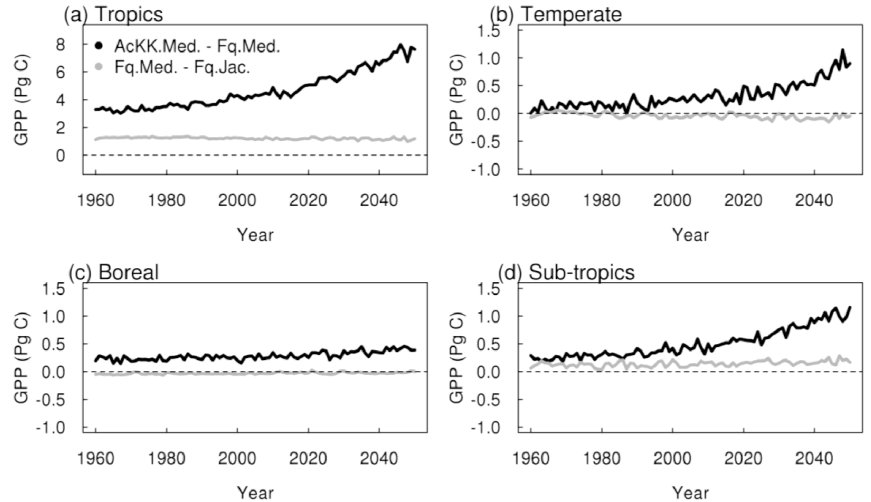
Figure 8. Time series of the regional mean acclimation effect, i.e AcKK.Med–Fq.Med (black), and the effect of the Medlyn g s model, i.e. Fq.Med–Fq.Jac